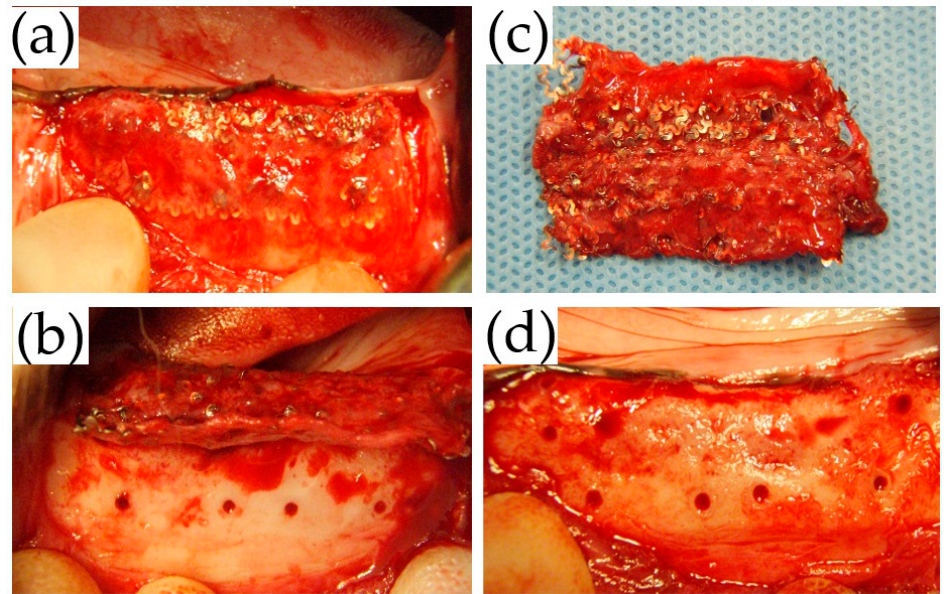
Figure 8. Macroscopic observation at membrane removal in the UFMP group. ( a , b ) It was difficult to elevate the mucoperiosteal flap, as well as the tissue beneath the membrane from the membrane because of the adhesion. ( c ) The membrane was extracted with the surrounding scar tissue. ( d ) The surface was replaced with the bone tissue.